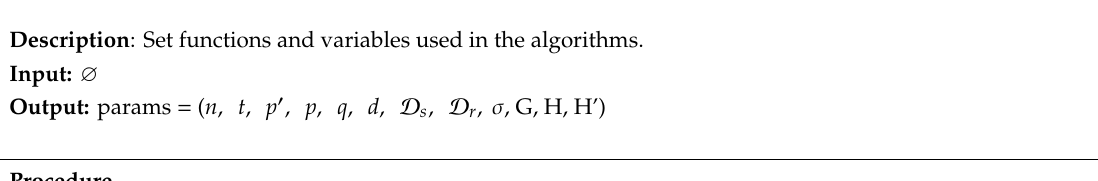
Algorithm 1. RLizard.KEM.Setup.